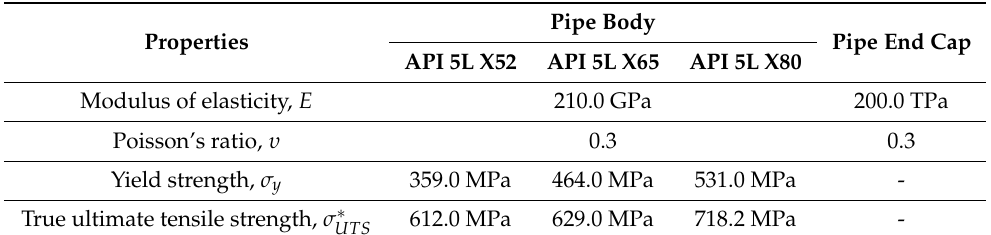
Table 3. Material properties of the pipe grades used in this study.